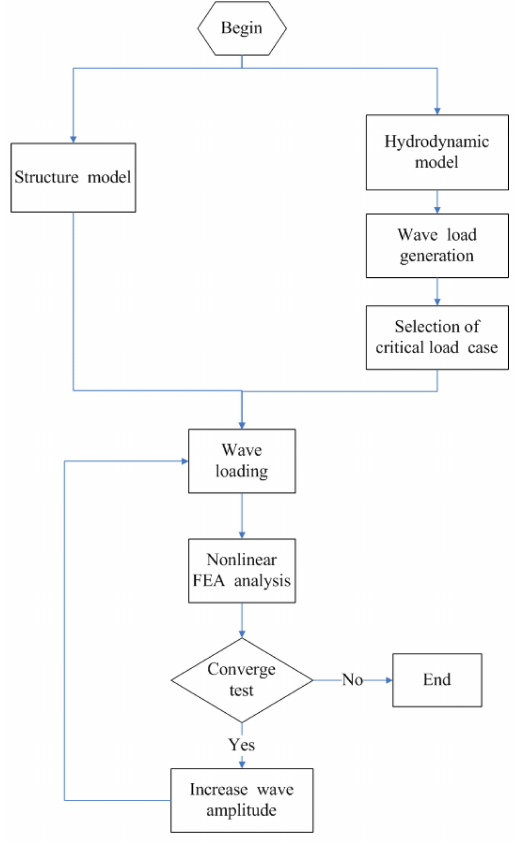
Figure 10. Procedure for the ultimate limit state assessment.